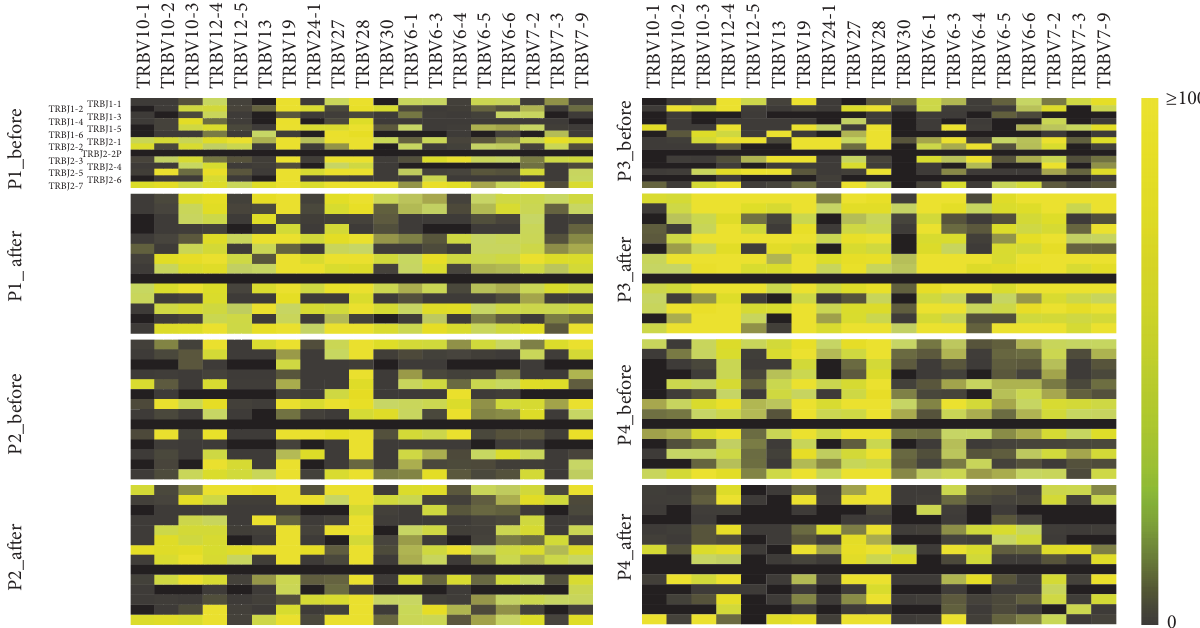
Figure 2: The serial results of TCR 𝛽 V J gene pairings in the four patients (P1–P4) before and after HBeAg seroconversion. TCR 𝛽 V J gene pairings were detected in the raw reads of four patients separately (both before and after treatment). Among the patients, there were several combinations that tended to be similarly differentially expressed following the shift from HBeAg positive to